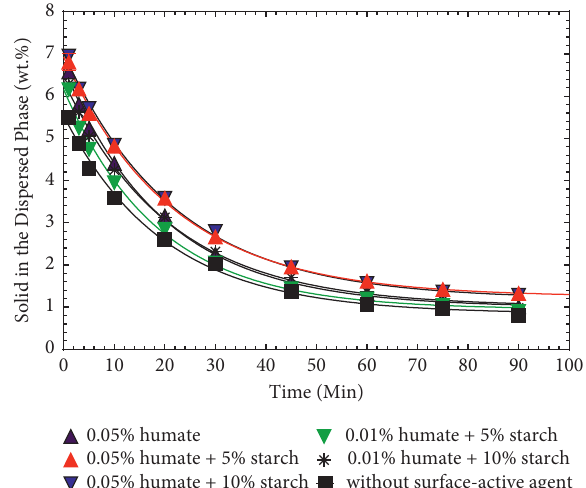
Figure 6: Stability of suspension in 10 wt. % slurry of slime at pH